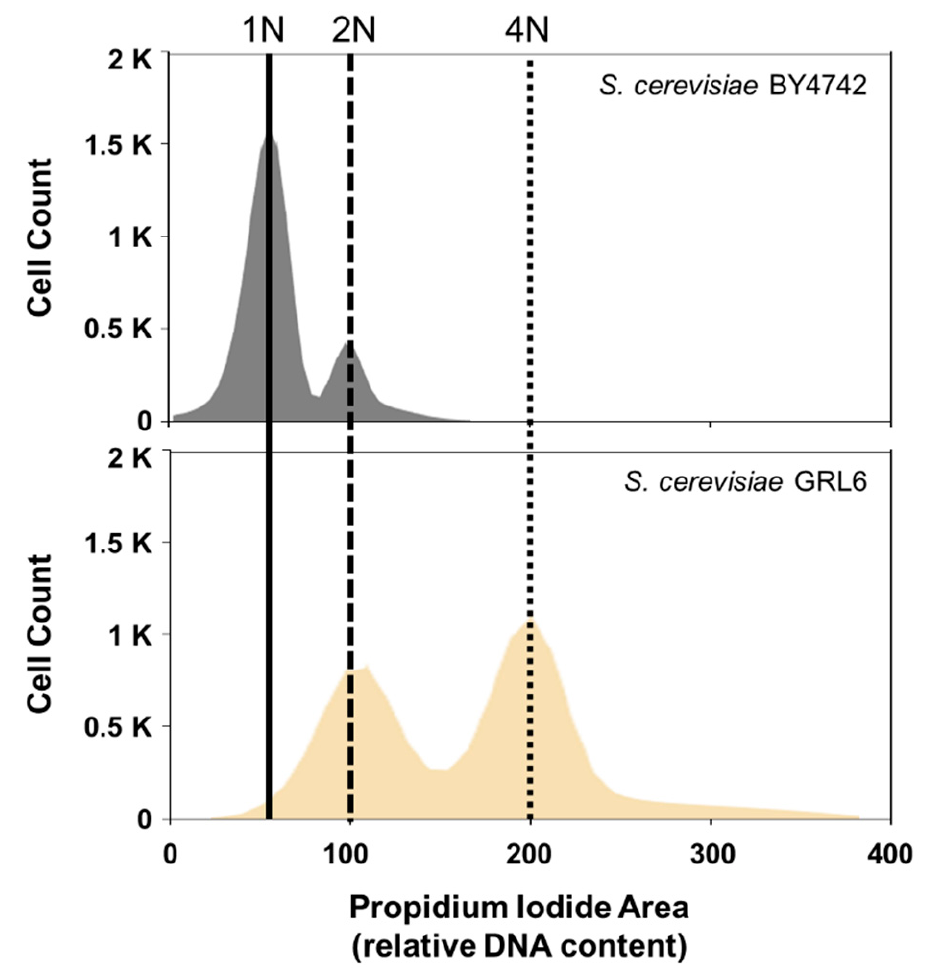
Figure 2. Determination of strain ploidy of industrial yeast isolated in this study. Nonparametric histogram shows the distribution of stained yeast cells according to their relative DNA content as examined by flow cytometry with propidium iodide (PI) dye using Texas Red filter. The S. cerevisiae BY4742 laboratory haploid strain was used as a reference strain. 1 N (haploid) S. cerevisiae BY4742 histogram for comparison are included at the upper part of the figure.